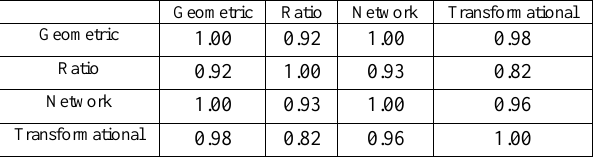
Table 6 Correlation of Running Example Semantic Similarity in different